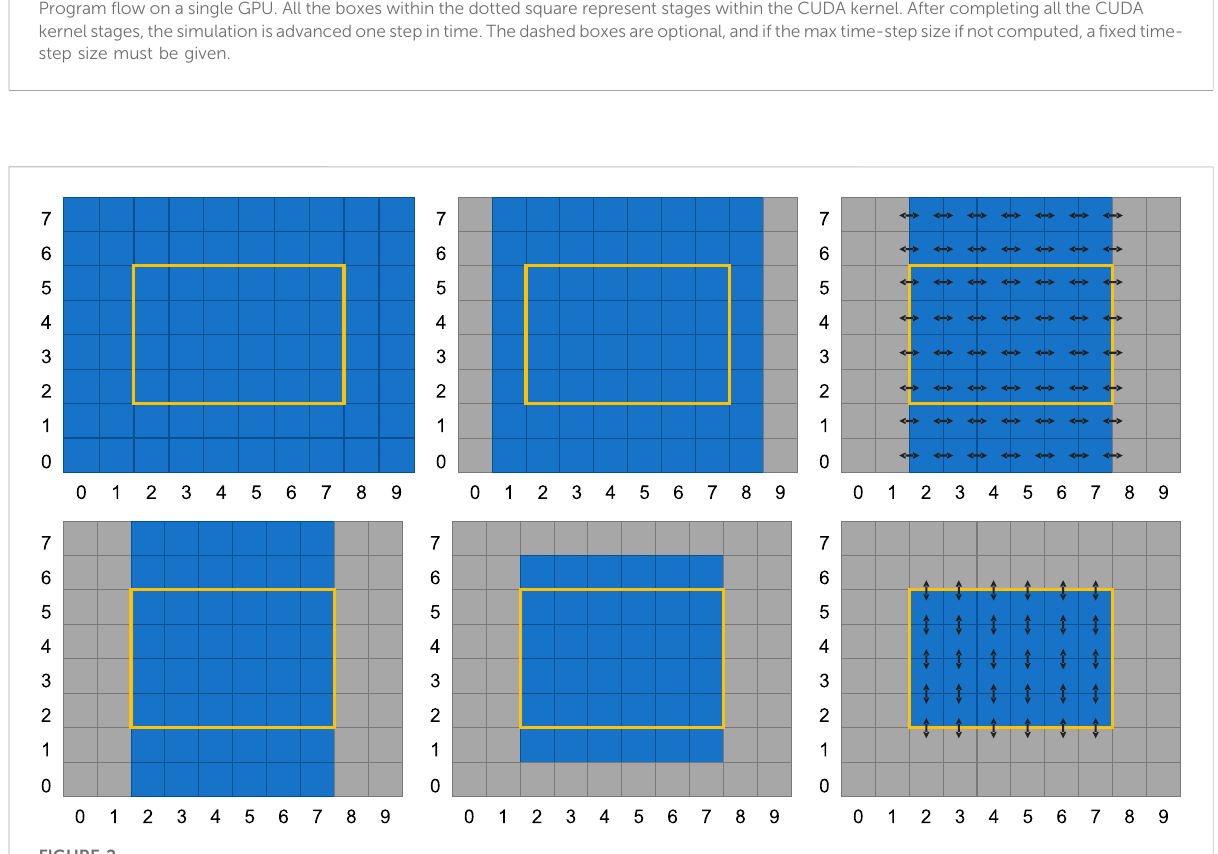
FIGURE 2 Halo region for theCUDA kernel whencomputing Eq. 8. The top row shows how theinput values(left) are used to compute theslopes (center) along the x-axis. The slopes are consequently used to compute the face fl uxes (right). Equivalently for the y-axis, the bottom row shows how the inputvalues(left)areusedtocomputetheslopes(center),and fi nallythe fl uxesalongthey-axis.Thus,aninputgridof8×10cellsisusedtocompute the fl uxes for the inner 4 × 6